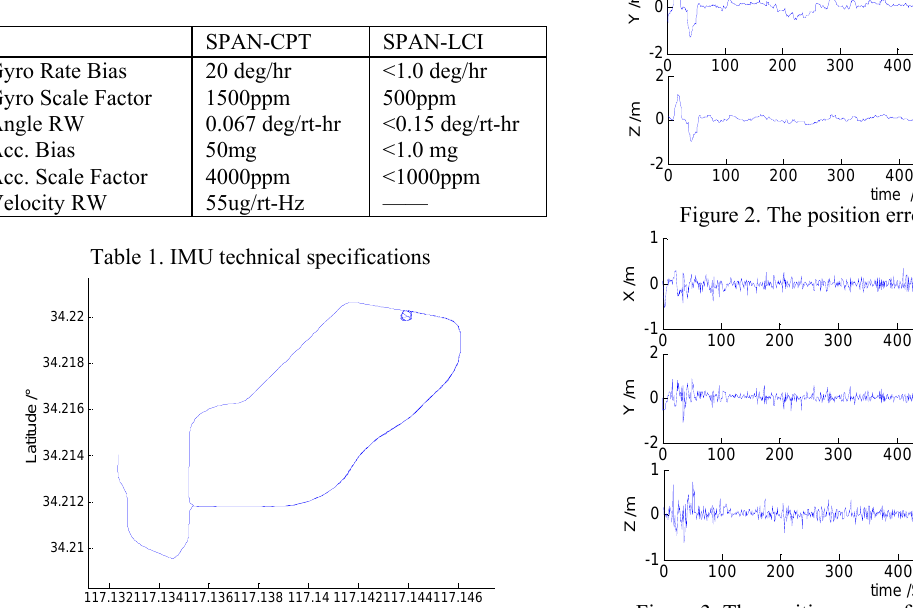
Figure 3. The position error of RCKF (  = 2) in case 1 RMS of Position Error (m)